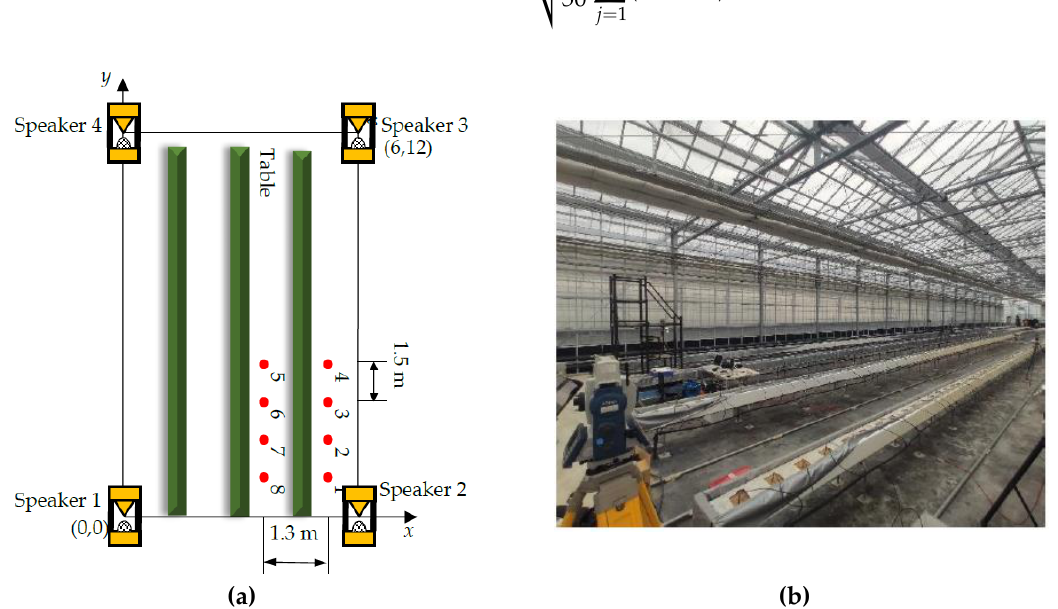
Figure 5. Experimental setup ( a ) and view ( b ) in the greenhouse.